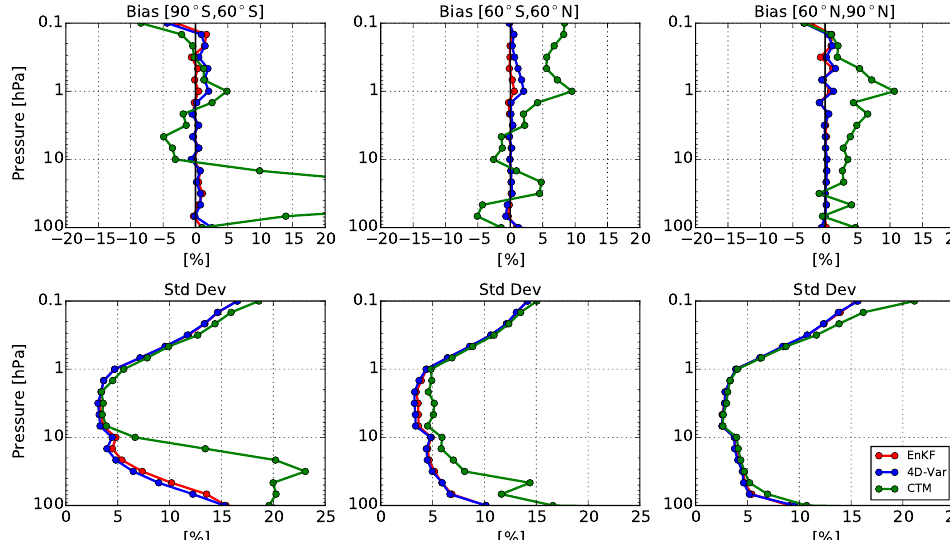
Figure 7. H 2 O OmF bias (top) and standard deviation (bottom) computed for the full chemistry CTM (green), EnKF (red) and 4D-Var (blue). OmF statistics are computed in percent with respect to the assimilated EOS Aura-MLS data for the period September–October 2008 and for three latitude bands (from left to right: South Pole, tropics–middle latitudes and North